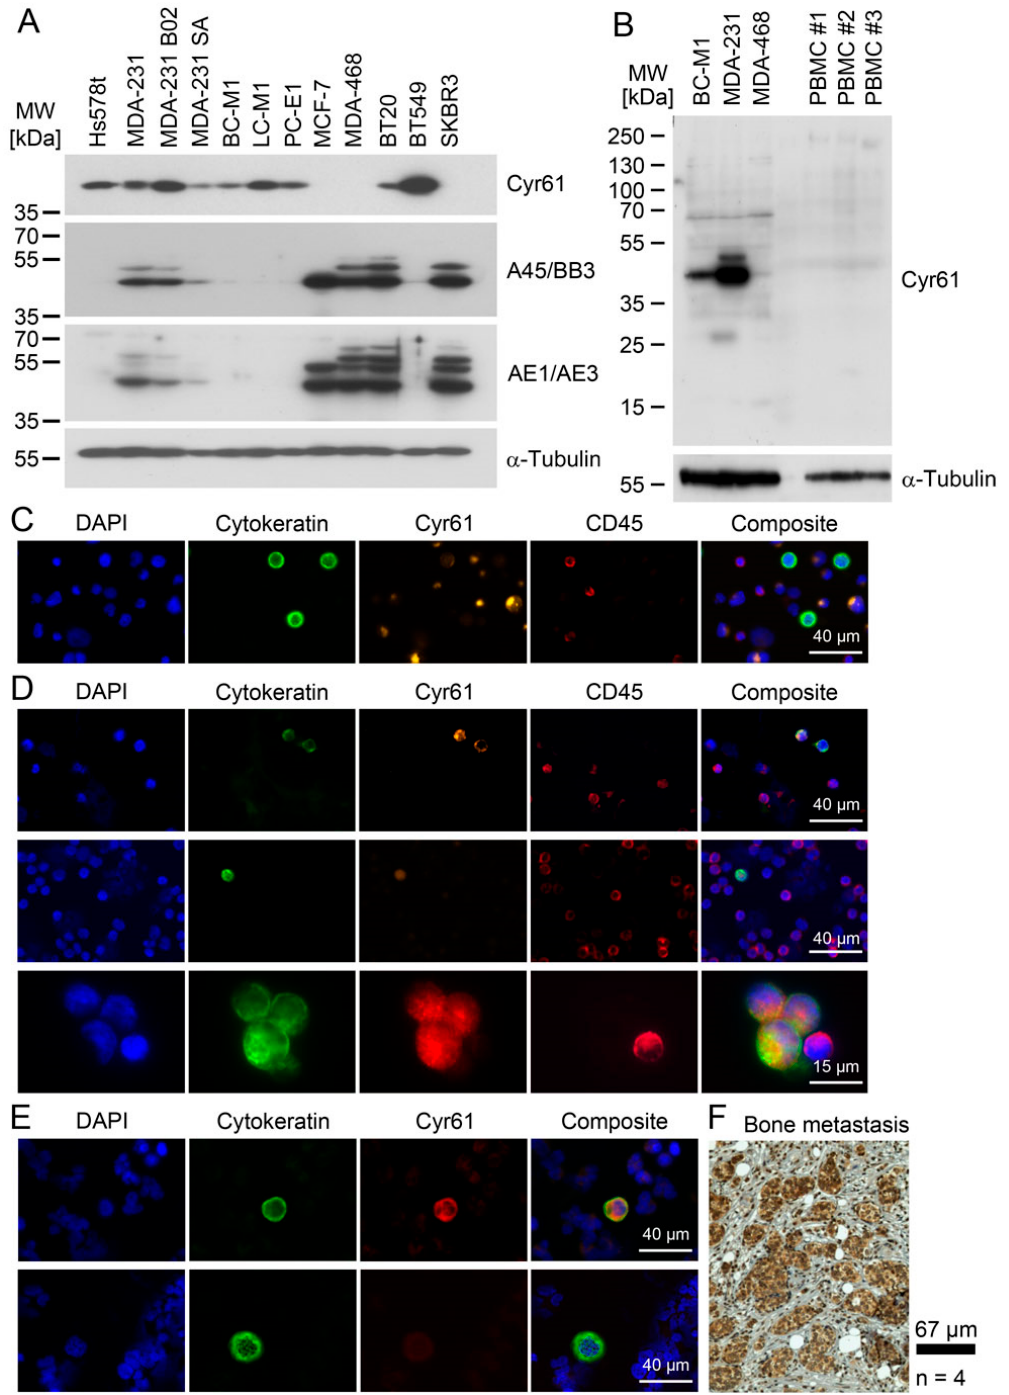
Figure 5. Cyr61 detection in breast cancer cells. ( A ) Comparison of the cytoplasmic Cyr61 levels with cytokeratin levels, as analysed by the pan-cytokeratin antibody cocktails A45/BB3 and AE1/AE3 by Western blot analysis. ( B ) A comparison of the Cyr61 levels in the peripheral blood mononuclear cells (PBMC) of healthy women with the Cyr61 levels in breast cancer cell lines. ( C ) Cyr61 detection in BC-M1 and MDA-MB-468 spiked into blood samples from healthy women by immunocytochemical double staining. ( D ) Cyr61 detection in CTC from the peripheral blood of breast cancer patients (details: Table 1). ( E ) Detection of Cyr61 in the DTC from the bone marrow of breast cancer patients. The upper row shows a Cyr61-positive DTC, and the bottom row shows a Cyr61-negative DTC. ( F ) An immunohistochemical Cyr61 detection in the bone metastases of breast cancer patients. ( C – E ) The composite images are overlays of the Cytokeratin, Cyr61, Dapi and CD45 (if applied) signals, n biol : 3 ( A , C , E ), 4 ( F ).